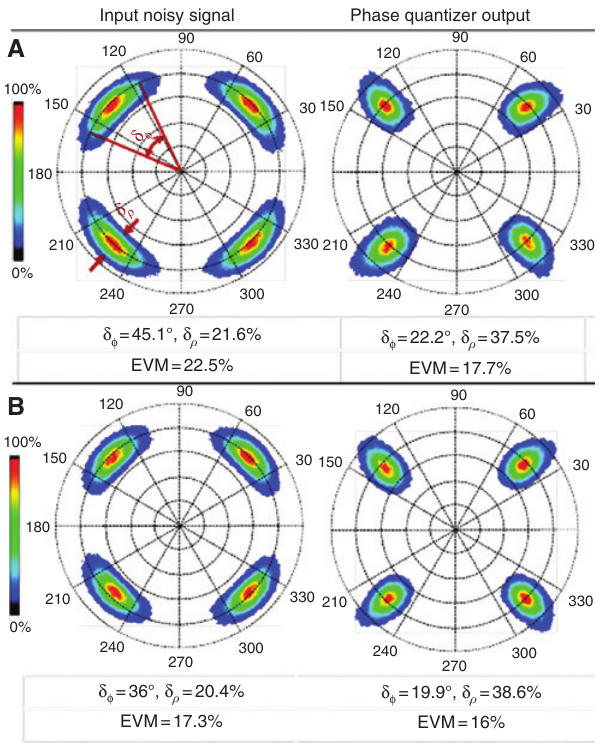
Figure 22: Non-PSA phase squeezing